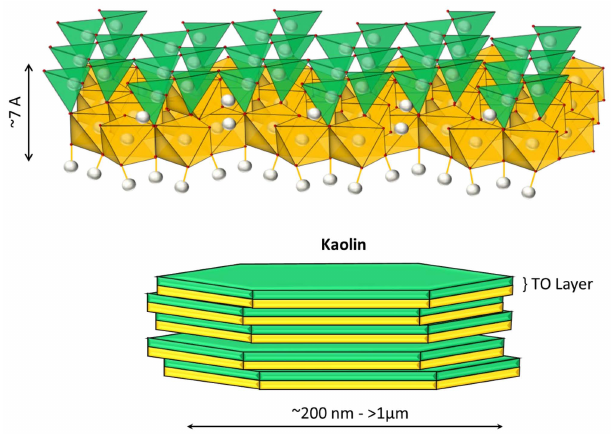
Figure 1. Kaolinite structure. The green sheet indicates the tetrahedral silica layer (T), and the yellow sheet represents the octahedral alumina layer